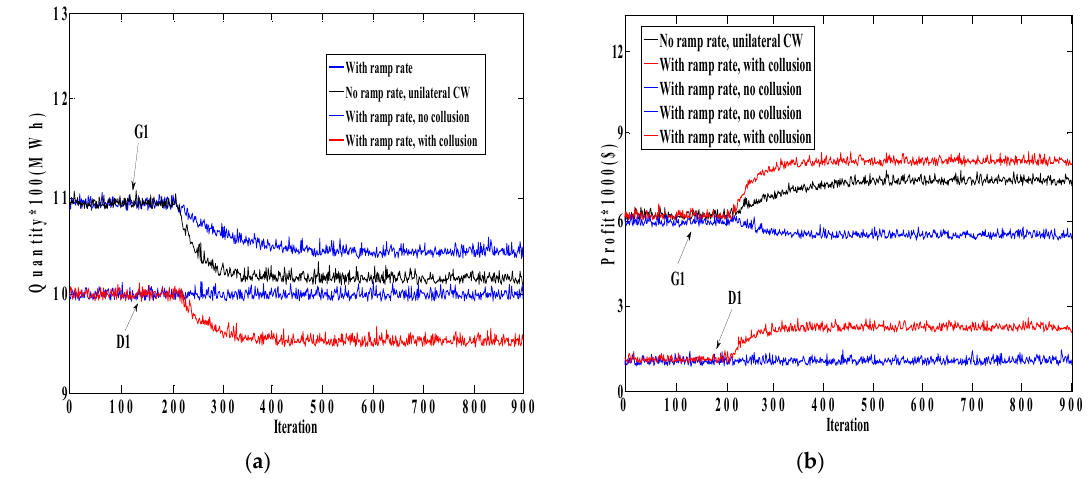
Figure 18. ( a ) Quantity bidding of G1 and D1 with and without ramp-rate constraint; ( b ) profit function of G1 and D1 with and without ramp-rate constraint.